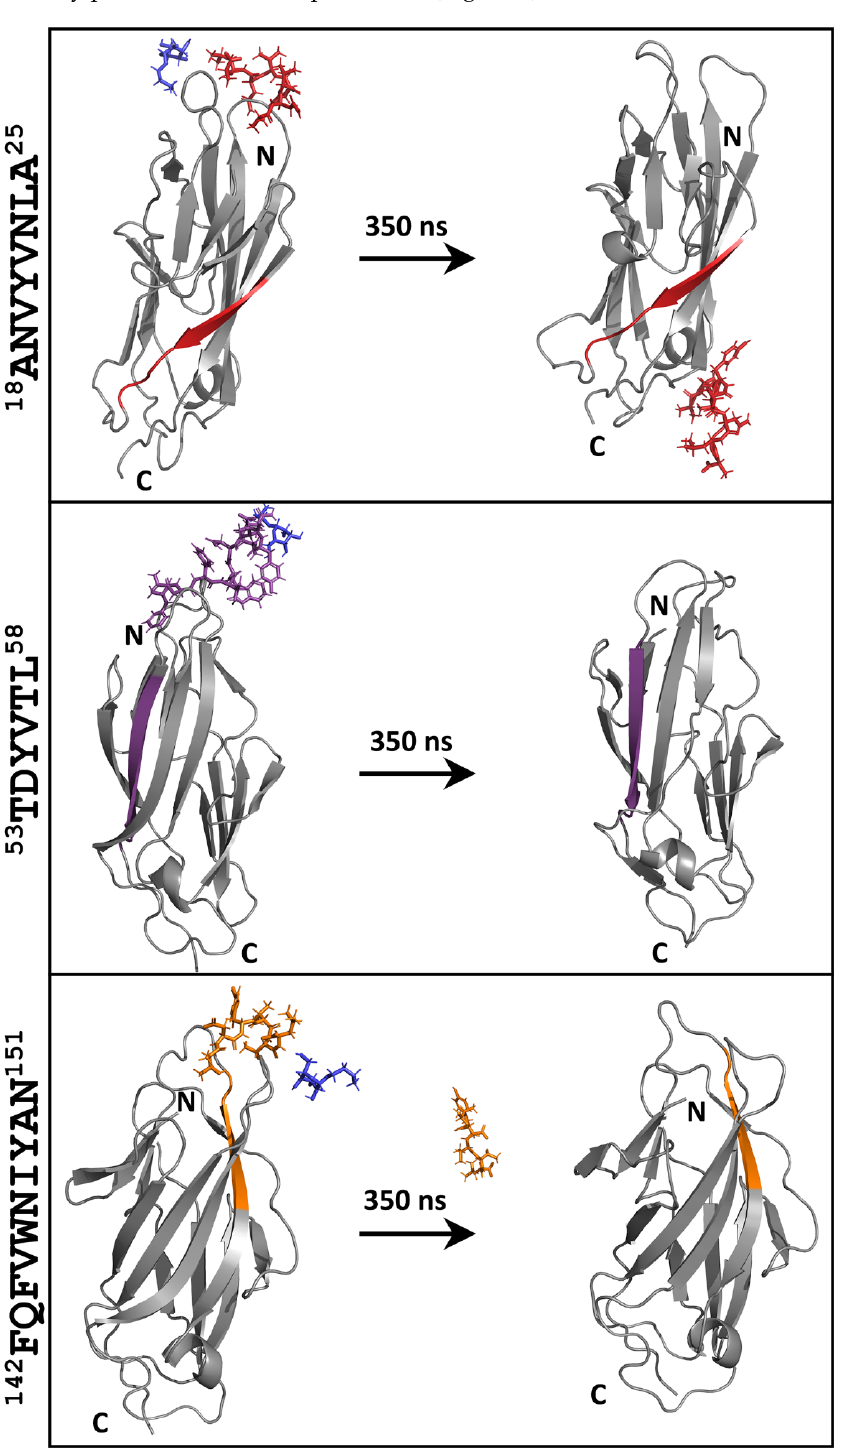
Figure 5. MD simulations of lectin domain-DEG-peptide-analogue complexes. In all three cases, the peptide-analogues moved away from the binding pocket of the lectin domain. 18 ANVYVNLA 25 , 53 TDYVTL 58 , 142 FQFVWNIYAN 151 , and DEG are colored in red, purple, orange, and blue (N: N-terminal, C: C-terminal).